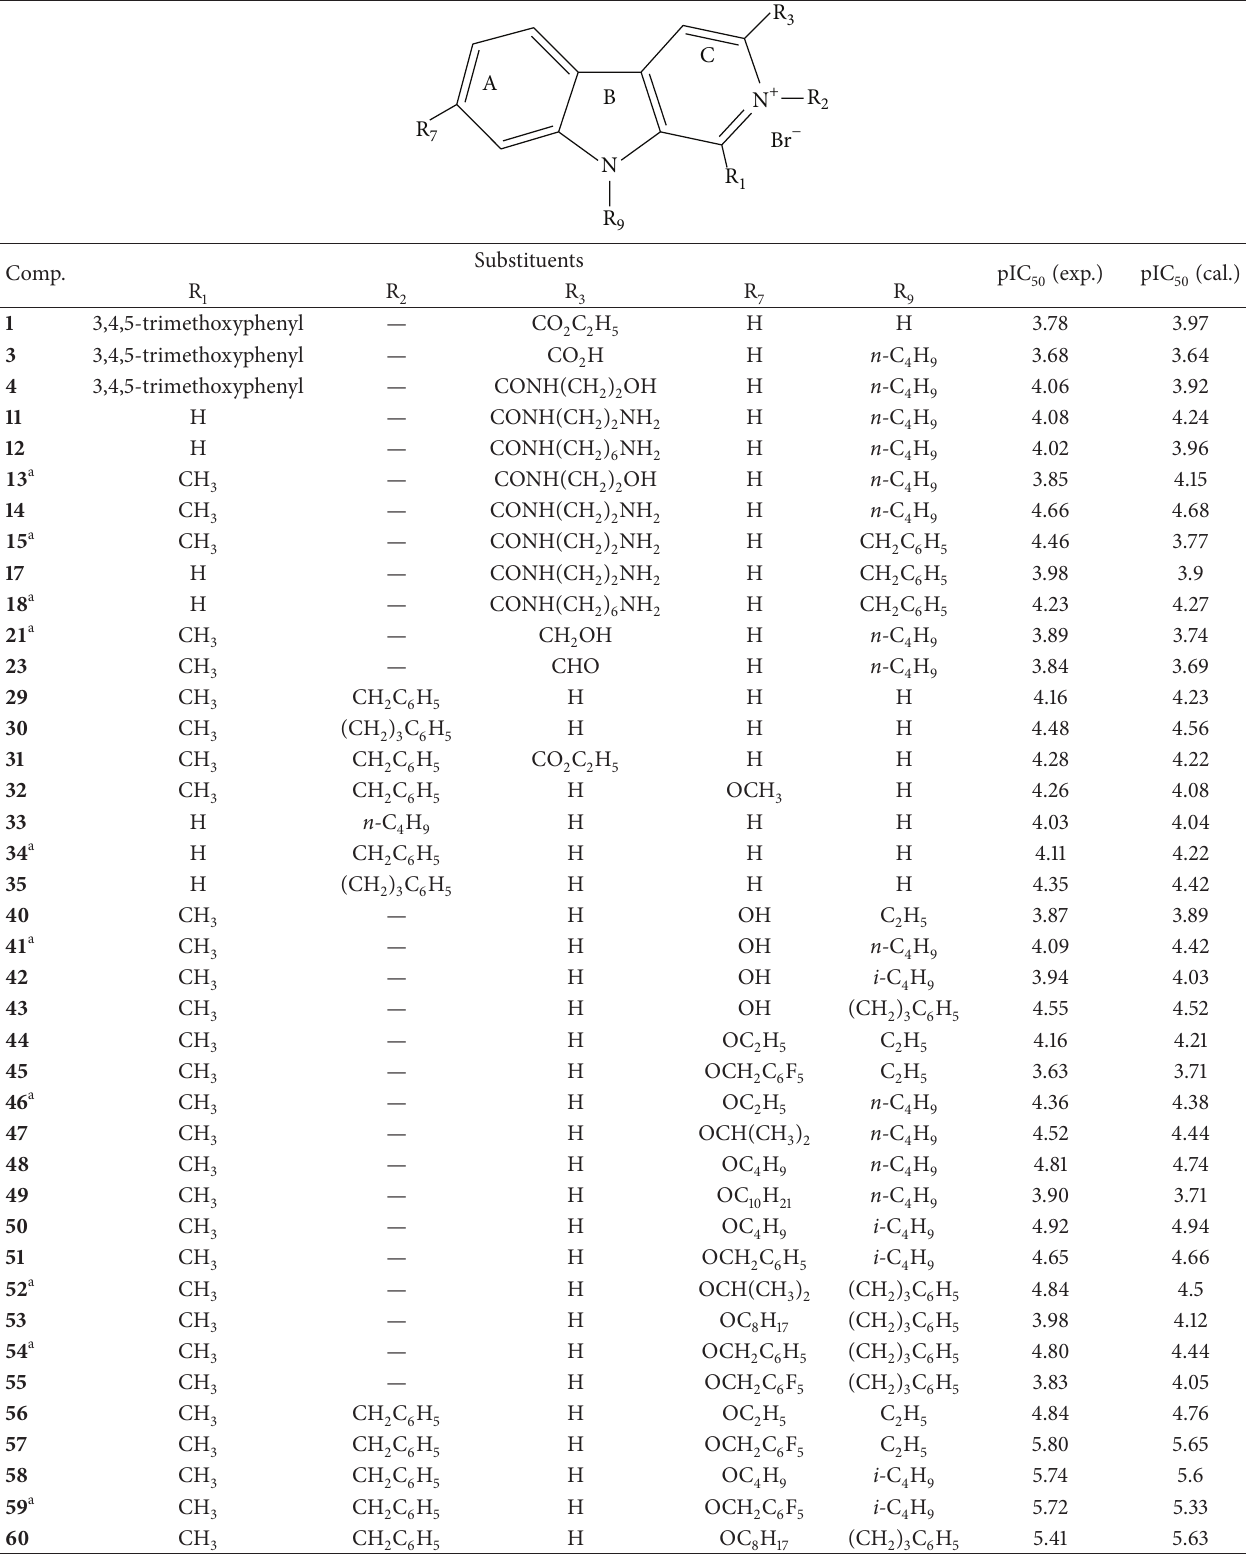
Table 1: Structures and potencies toward HepG2 tumor cell lines of compounds 1–40